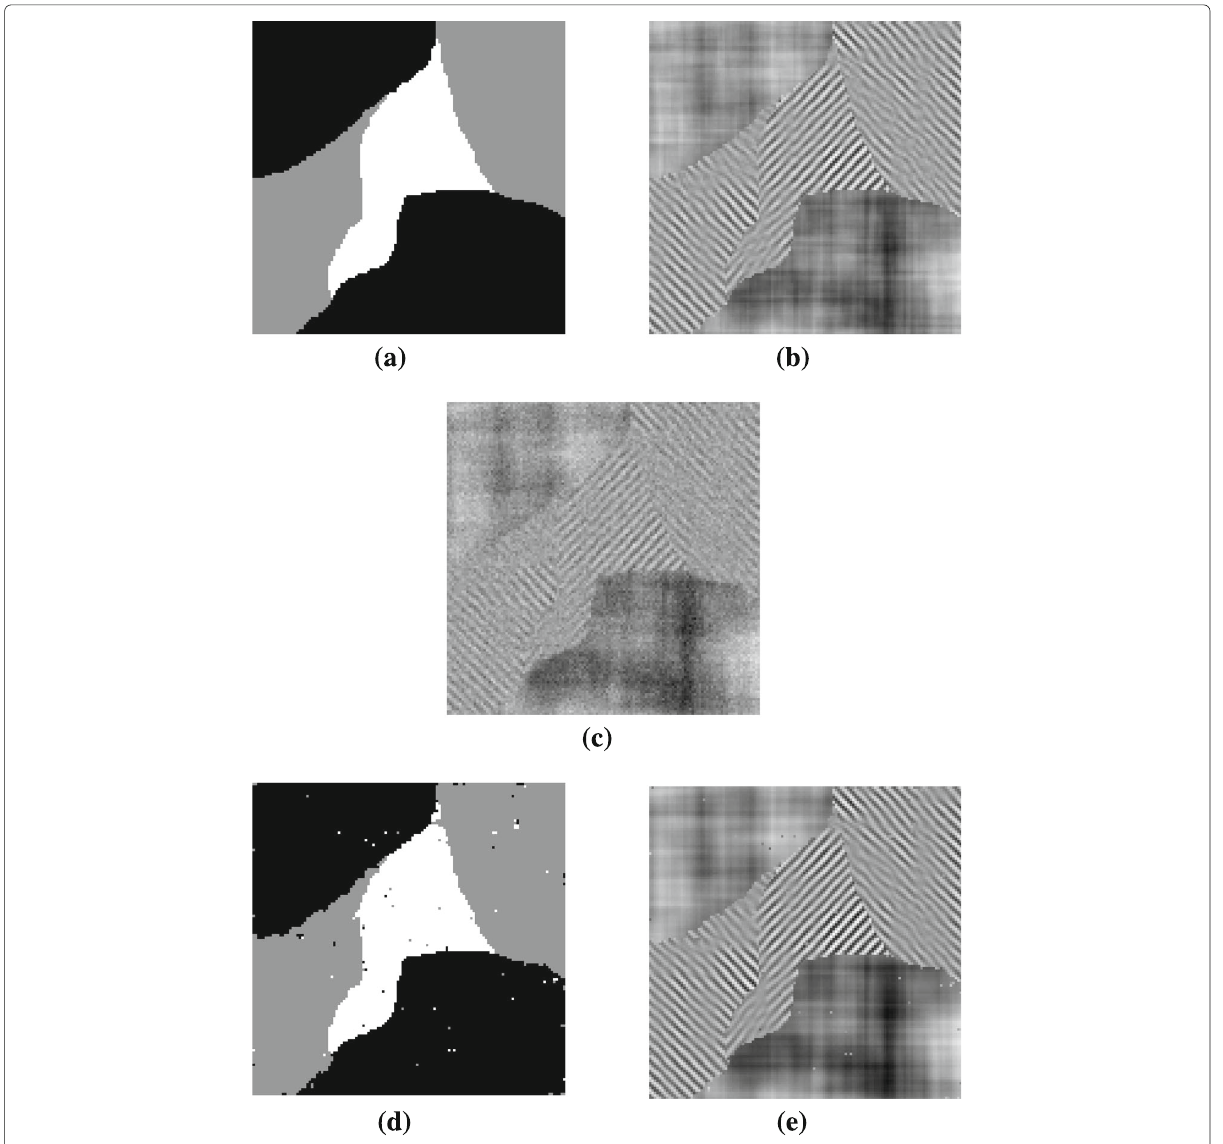
Fig. 4 Segmentation and reconstructed images (Example 1). a True labels (cid:2) ∗ . b True image z ∗ . c Data y . d Estimated labels ˆ (cid:2) . e Estimated image ˆ